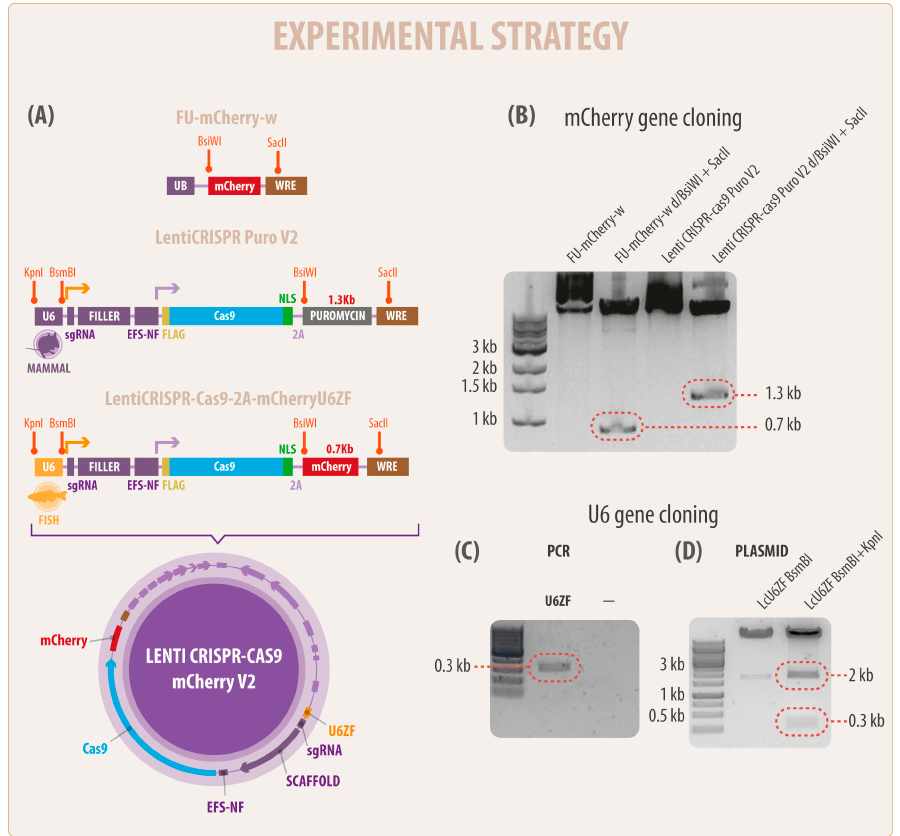
Figure 1. A simplified diagram of the development of a new clustered regularly interspaced short palindromic repeats/CRISPR-associated protein 9 (CRISPR Cas9) vector in fish cells. ( A ) In the left panel and in colors are represented the names and sizes of the regulatory elements including RNA pol III U6 (U6), short EF1alpha (EFS-NS) promoter, small guide RNA (sgRNA), the antibiotic resistance cassette (puromycin), and the mCherry gene. The novel fish U6 promoter (zebrafish U6 RNA III polymerase (U6ZF) ligated in the new vector is represented in yellow. In orange are highlighted the recognition sequences of the restriction enzymes used in this work ( Bsi WI, Sac II, Kpn I, and BsmB I, respectively). Arrows indicate the downstream activity of U6ZF (yellow) and EFS-NS (violet) promoters. Note that lentiviral elements were omitted in this representation. ( B ) Molecular characterization and isolation of mCherry gene from FU-mCherry-w plasmid (lane 1). In lane 2, a single 0.7 kb fragment (red frame) corresponding to the mCherry sequence was obtained by double digestion (BsiWI and SacII). Lane 3 represents the LentiCRISPR-Cas9 PuroV2 (14 kb) vector, whereas the isolation and removal of puromycin cassette 1.3 kb fragment (red frame) was obtained using the same enzymes mentioned above. ( C ) PCR product of U6 promoter from zebrafish genomic DNA; and ( D ) the new vector LcU6ZF containing the new fish promoter (0.3 kb) highlighted in red, as well as filler fragment (2 kb). 3.2. CHSE/F Transfected Cells Expressing both sgRNA and Cas9 The functionality of the U6ZF and EFS-NS promoters to generate the sgRNA and Cas9 mRNA in the CHSE/F cells was assessed by RT-PCR. The results showed that CHSE/F cells transfected with the LcU6ZsgGFP plasmid were able to transcribe (96 bp) sgRNA from the U6 zebra fish promoter (Figure 2A). We also demonstrated that the EFS-NS mammalian promoter, the shorter form of a